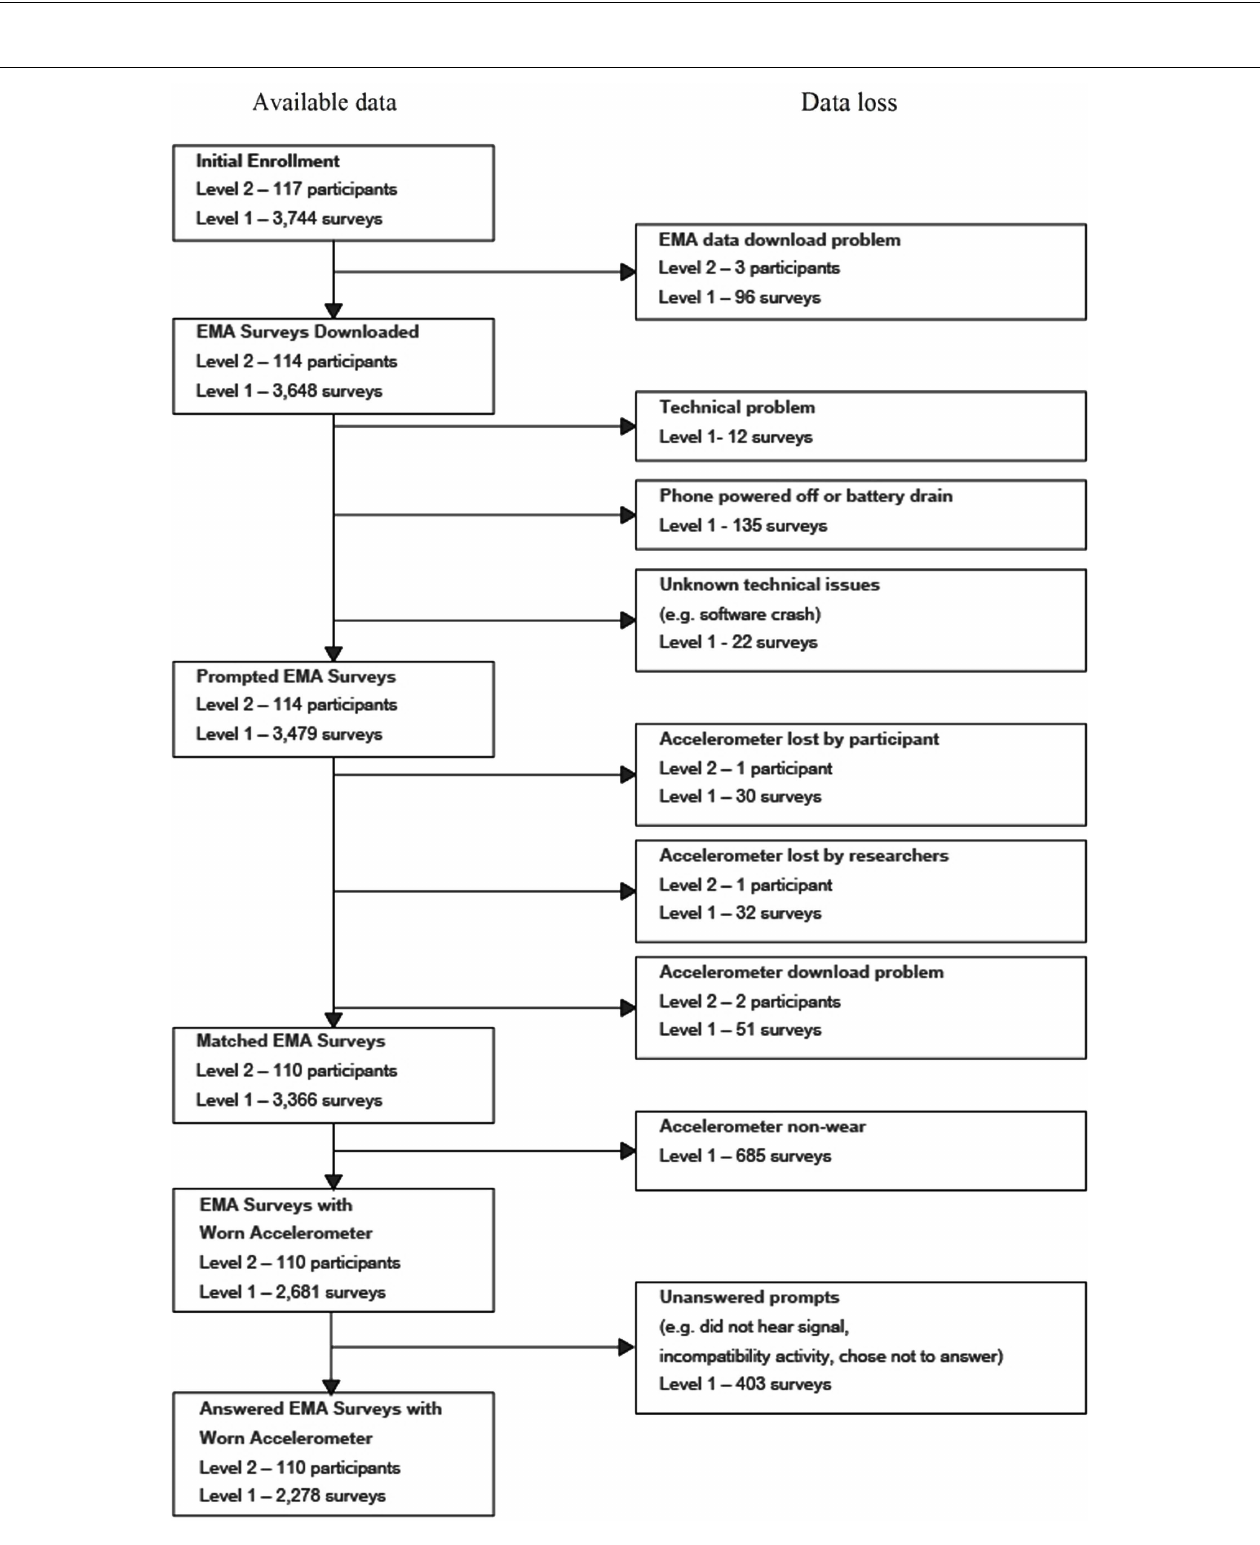
FIGURE 3 | Flow chart of data availability. Level 1 represents the number of electronic Ecological Momentary Assessment (EMA) surveys, and Level 2 represents the number of participants. EMA Surveys Downloaded = the number of EMA surveys successfully downloaded from the mobile phone. Prompted EMA Surveys = the number of EMA surveys with a time and date record of being prompted. Matched EMA Surveys = the number of prompted EMA surveys that could be time-matched to available accelerometer